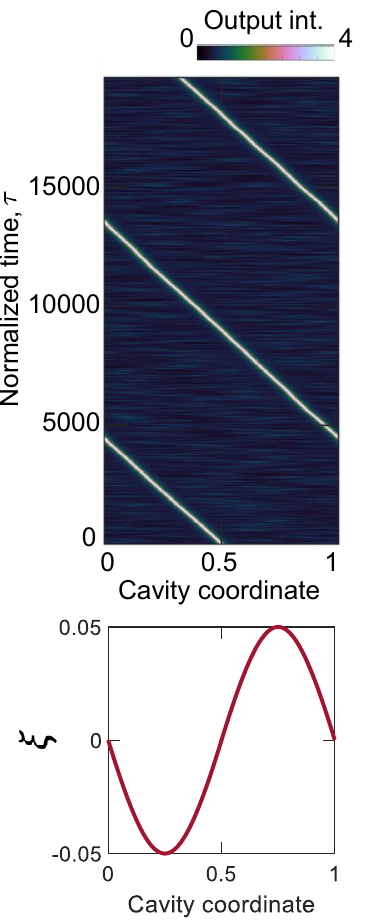
Figure12: Acavitysoliton(CS)driftscontinuouslyalongthecavityin presence of pump modulation, plotted in the lower panel. Here Y = 6.7 and ξ 0 =